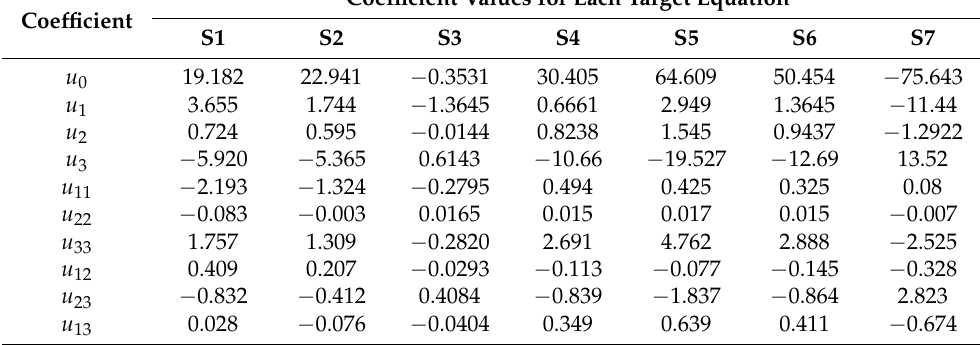
Table 3. Values for